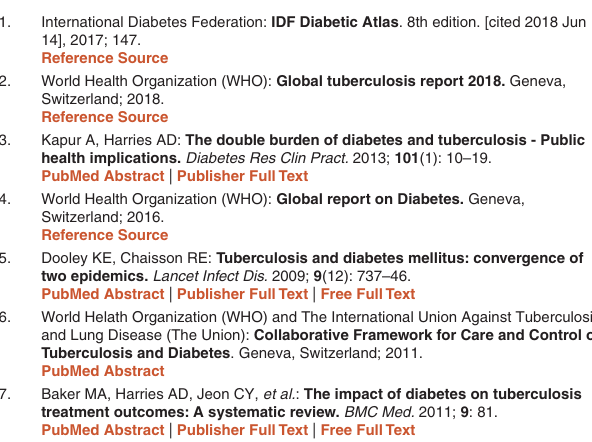
Figshare: Data set for Gurukartick study 2016. https://doi. org/10.6084/m9.figshare.9902180 18